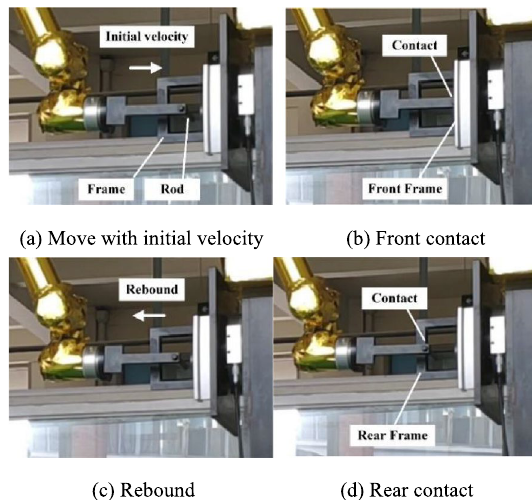
Figure 11 Practical contact